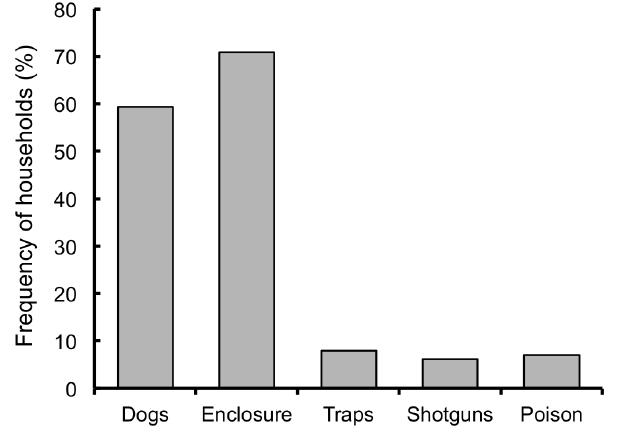
Figure 3. Measures of farm animal protection in rural areas in southern Chile. Measures of farm animal protection against carnivore predators reported by rural interviewees around three protected areas in southern